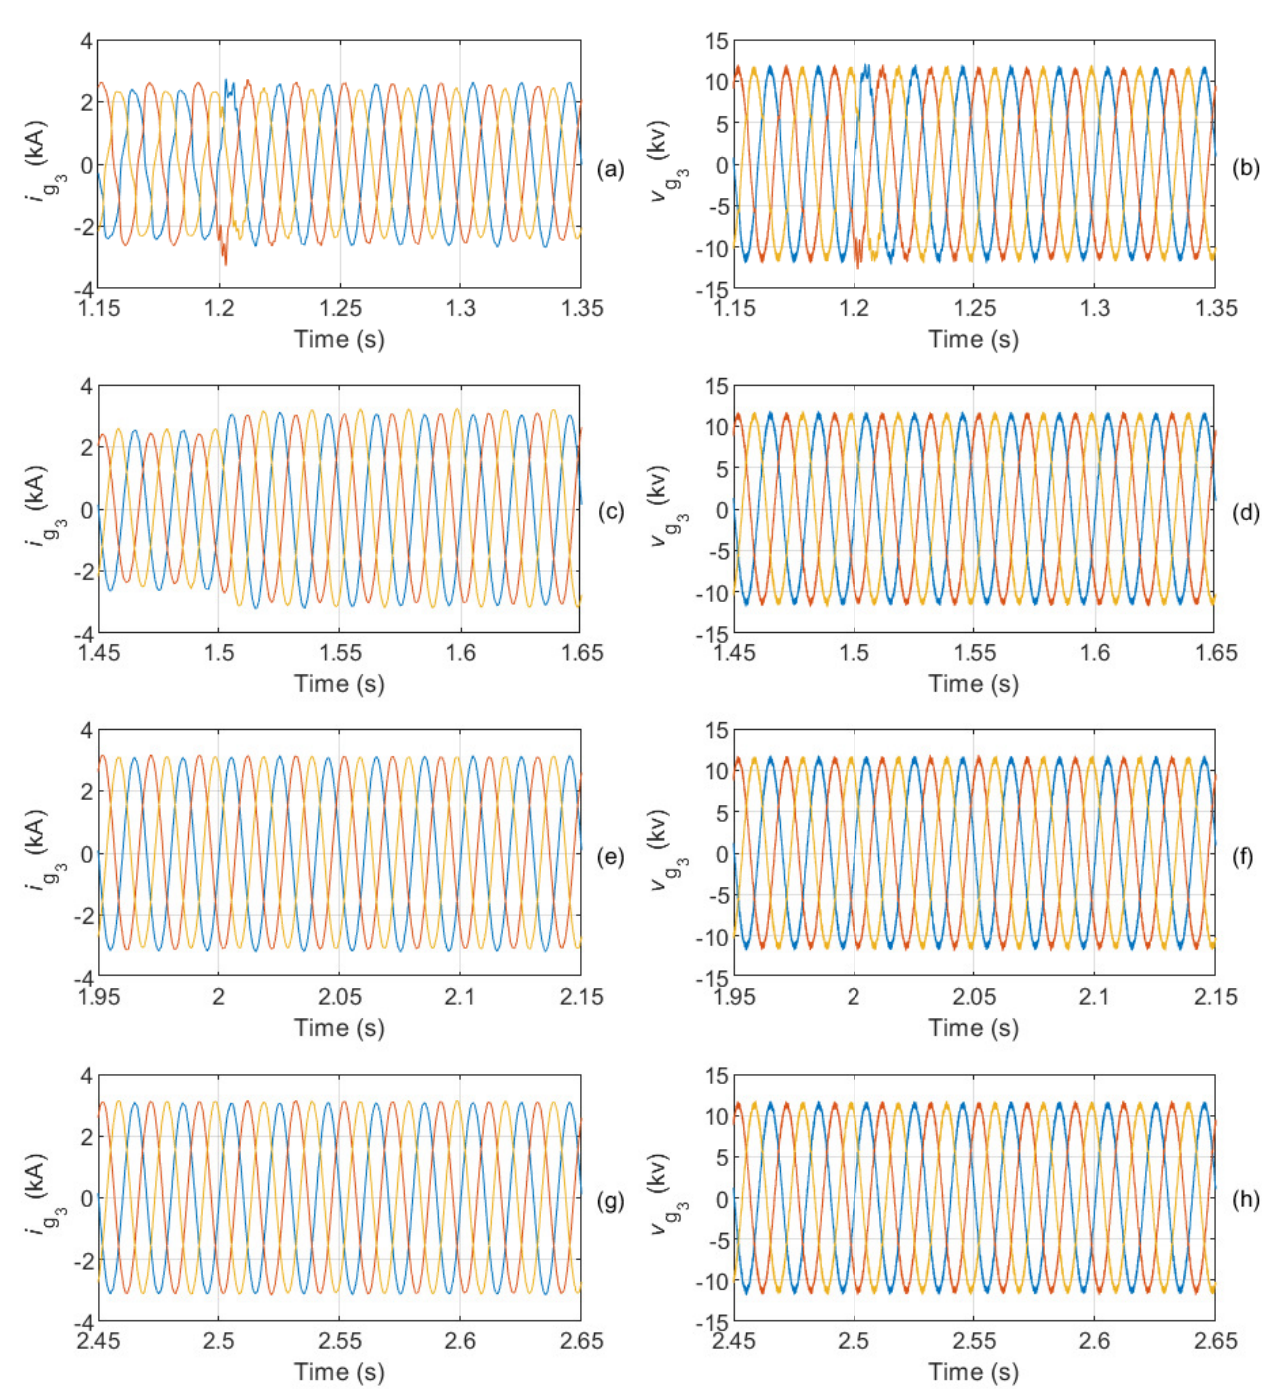
1.35 s), t ≤ ≤ 1.65 s), ( d ) line-to-neutral t ≤ ≤ 2.15 s), ( f ) line-to-neutral voltages at PCC 3 t ≤ ≤ 2.65 t ≤ ≤